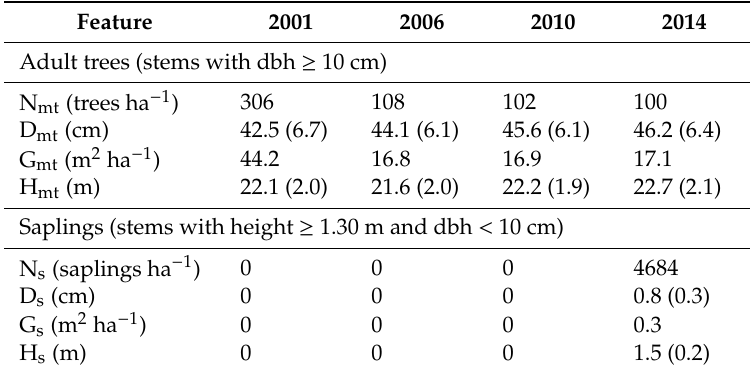
Table 1. Number of stems per hectare (N), mean diameter (D), basal area (G) and mean height (H) of the adult trees and the saplings (subindices mt and s, respectively) during the four